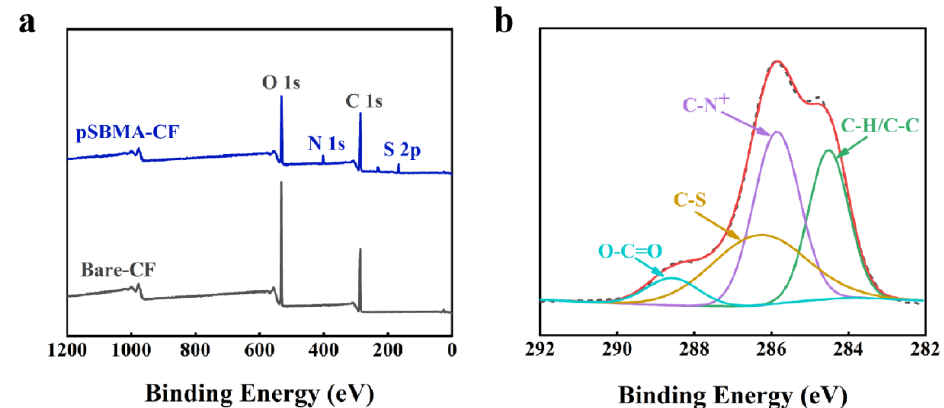
Figure 2. ( a ) The XPS spectra of bare-CF and pSBMA-CF; ( b ) representative XPS high-resolution C1s spectra of pSBMA-CF.